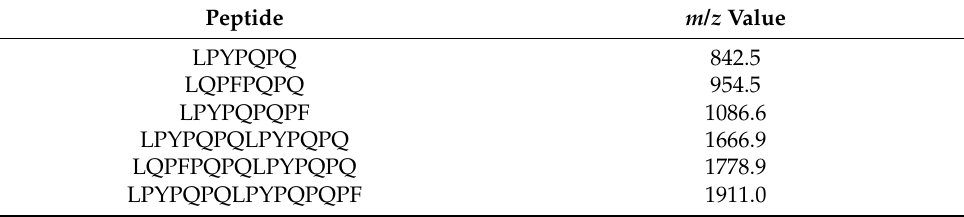
Figure 12. Mass spectra of the original 33-mer LQLQPFPQPQLPYPQPQLPYPQPQLPYPQPQPF peptide ( A ) and hydrolysate by rTcCathL1 after 40 min of incubation ( B ), where (1), (2), (3), (4), (5), and (6) are the LPYPQPQ, LQPFPQPQ, LPYPQPQPF, LPYPQPQLPYPQPQ, LQPFPQPQLPYPQPQ, and LPYPQPQLPYPQPQPF peptides, respectively. Table 1. Major products of the hydrolysis of the 33-mer peptide by